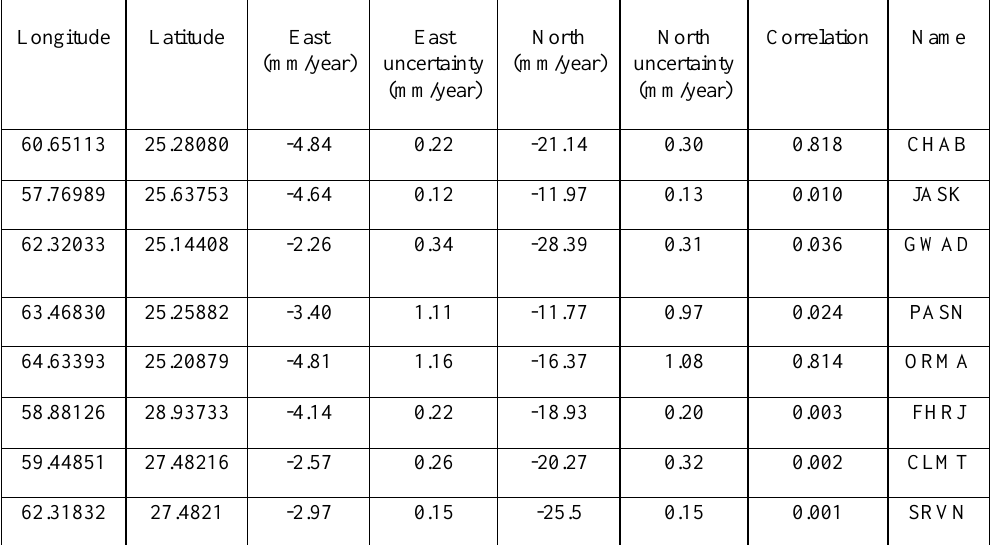
Table 2. Velocity vectors rotated relative to the plane of Arabia and used in the